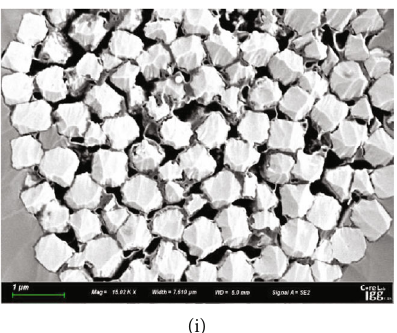
Figure 10: Field emission scanning electron microscope (FE-SEM) images of limestone samples. The type of pores is relatively simple for limestone samples, with mainly (a – h) organic matter-hosted pores, (b, c, h) carbonate dissolution pores, and (i) pyrite intergranular pores. (a, b) Sample 2164.59; (c) sample 2164.73; (d, e) sample 2165.06; (f) sample 2185.55; (g) sample 2189.35; (h) sample 2195.28; (i) sample